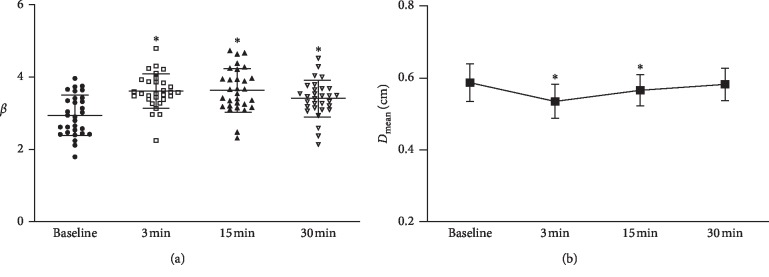
(a) Arterial stiffness (β). (b) Mean arterial diameter (Dmean).